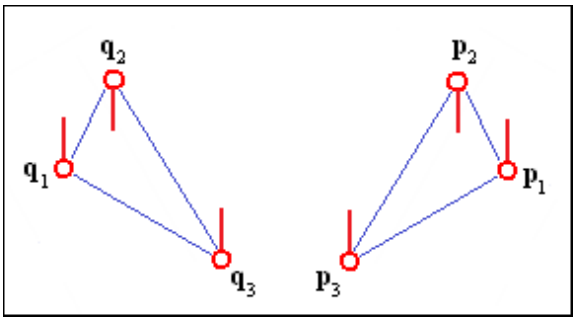
Figure 2. Minutiae triplets that do not match because ( p ( q ; q ; q ) . 1 2 3